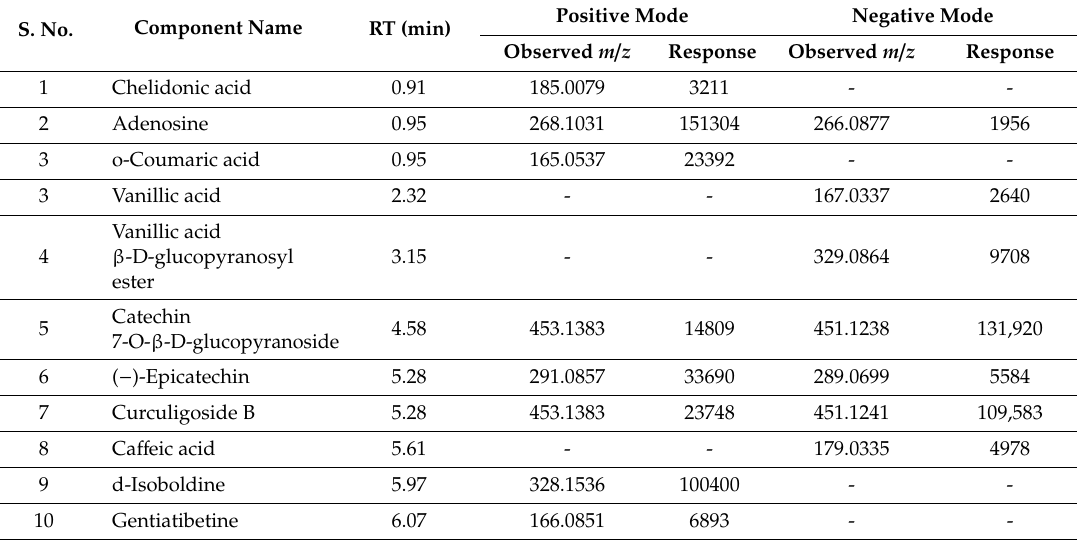
Table 2. UPLC–MS QTof identified compounds of the Gloriosa superba seed in the positive and the negative